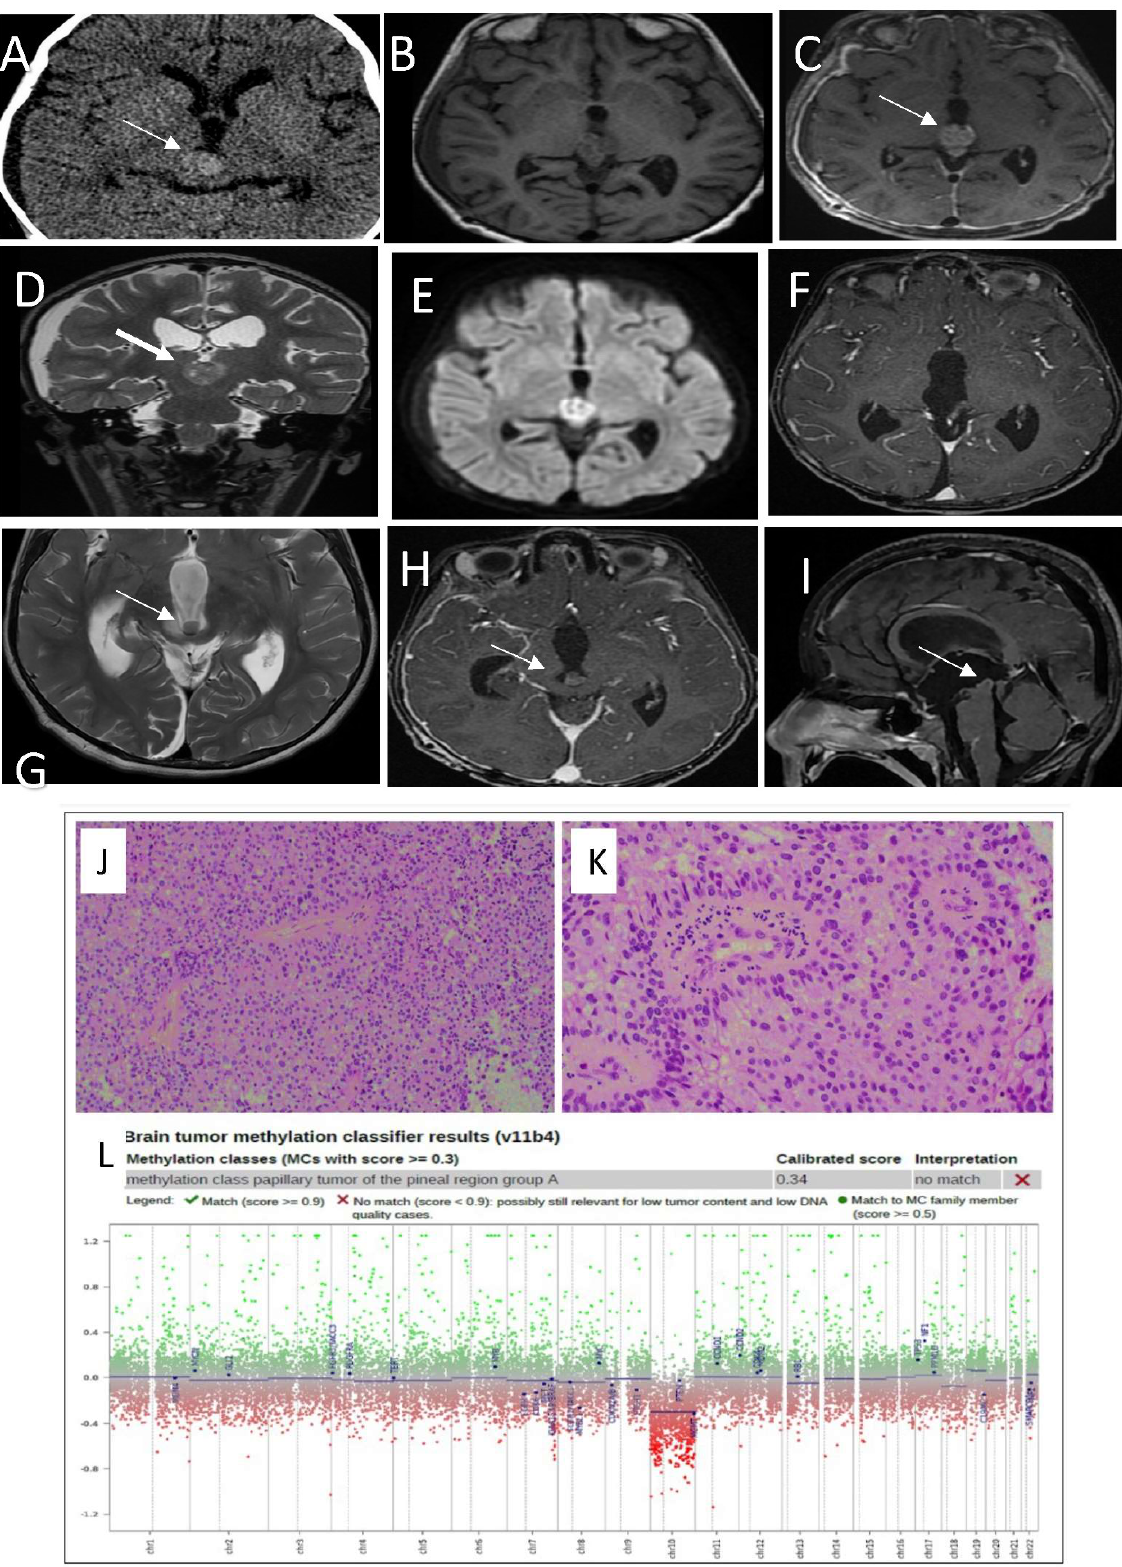
Figure 3. (A ) CT scan shows a hyperdense pineal gland mass with no calcification (arrow). ( B ) SE T1W MRI shows an isointense lesion with peripheral areas of hyperintensity. ( C ) Post-contrast T1W MRI shows enhancement of the lesion (arrow). ( D ) T2WI in coronal plan shows a low signal inten- sity behavioral appearance of the lesion. ( E ) Diffusion weighted images show bright signal indica- tion diffusion restriction (ADC not shown) ( F ) Post-contrast T1W MRI after the first resection shows gross total resection. ( G ) Follow-up MRI T2 WI shows a recurrent lesion in the posterior inferior aspect of the third ventricle (arrow) with mass effect. ( H – I ) Post contrast T1W MRI in axial and sagittal shows the recurrent lesion. Histologic features of the tumor assessed by routine hematoxylin and eosin staining demonstrate ( J ) a mainly solid growth pattern with round-oval nuclei and abun- dant clear cytoplasm and ( K ) short columnar perivascular cells with clear cytoplasm. ( L ) DNA meth- ylation class PTPR Group A. Histopathology analysis revealed a PTPR (Figure 3J-K) with papillary infiltrates showing necrotic foci and a moderate proliferative index and absence of mitotic activity. Methylation class analysis identified a papillary tumor of the pineal region group B (Figure 3L). CSF cytology showed inflammatory cells. No malignant cells were detected (not shown). As discussed in the multidisciplinary neuro-oncology tumor board, the patient was planned for observation and MRI follow-up. She remained well until one-year post-diag- nosis, when she came to the ER with headache, lethargy, and signs of raised intracranial pressure (ICP), and was admitted to the PICU. A brain MRI showed a recurrent pineal region tumor measuring 0.9 x 0.9 x 0.7 cm in AP, TR, and CC, respectively. The lesion was situated in the posterior aspect of the third ventricle and embedded in the proximal cerebral aqueduct, causing secondary obstructive hydrocephalus with a mass effect on the tectum, which was displaced posteriorly (Figure 3G–I); MRI of the spine was unremarkable (not shown). She had emergency EVD insertion to relieve ICP. The neurosurgical team felt that the recurrent tumor was unresectable, so permanent right parietal VPS was inserted with marked clinical and neurological improvement. Lumbar puncture for CSF cytology showed atypical cells, indicating microscopic CSF dissemination. She was started on